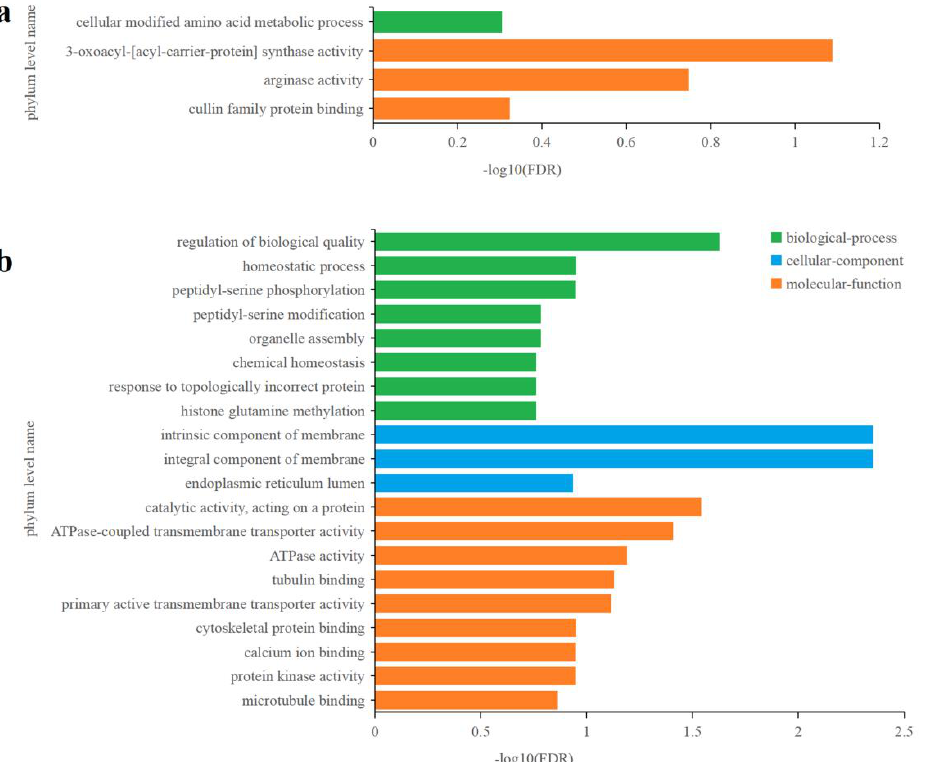
Table 4. DEGs involved in heavy metal stress response in C. fusiformis under Zn 2+ .